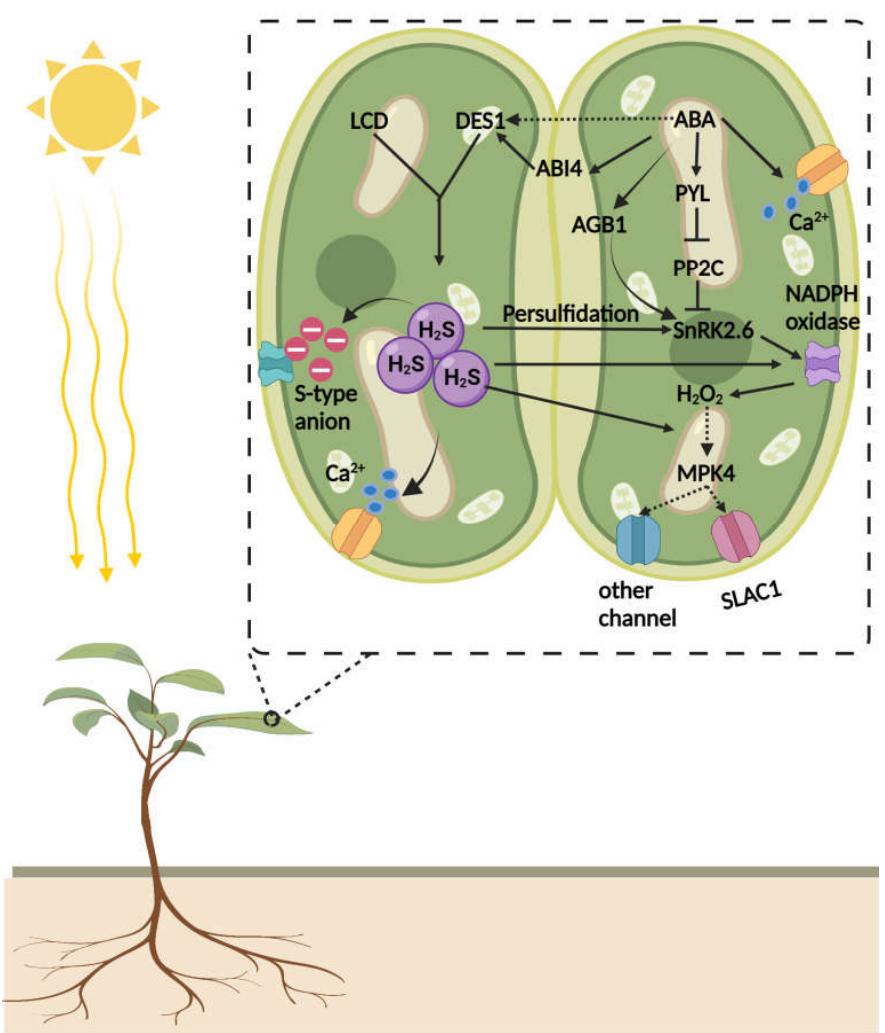
Figure 4. Under normal conditions, ABA receptors (PYR/PYL/RCAR) bind to the PP2Cs and inhibit the activity of SnRK2.6, which deactivates NADPH oxidase, SALC1, and other ion channels to reinforce the normal functioning of stomata. Under water-stressed conditions, ABA signaling stimulates ABA receptors (PYR/PYL/RCAR) that lead to the activation of SnRK2.6, which triggers SLAC1 and NADPH oxidase to produce H 2 O 2 and regulate stomatal movements. During drought stress, ABA signaling increases the biosynthesis of H 2 S via persulfidation of ABI4-mediated activation of DES1 transcription. The burst of H 2 S in guard cells activates the S-type anion and spikes the Ca 2+ wave alongside strong persulfidation of SnRK2.6. The persulfidated SnRK2.6 robustly phosphorylates SALAC1 and NADPH oxidase to produce a long-lasting burst of ROS to modulate water efflux in guard cells to close stomata, similarly to the way that ABA induces stomatal